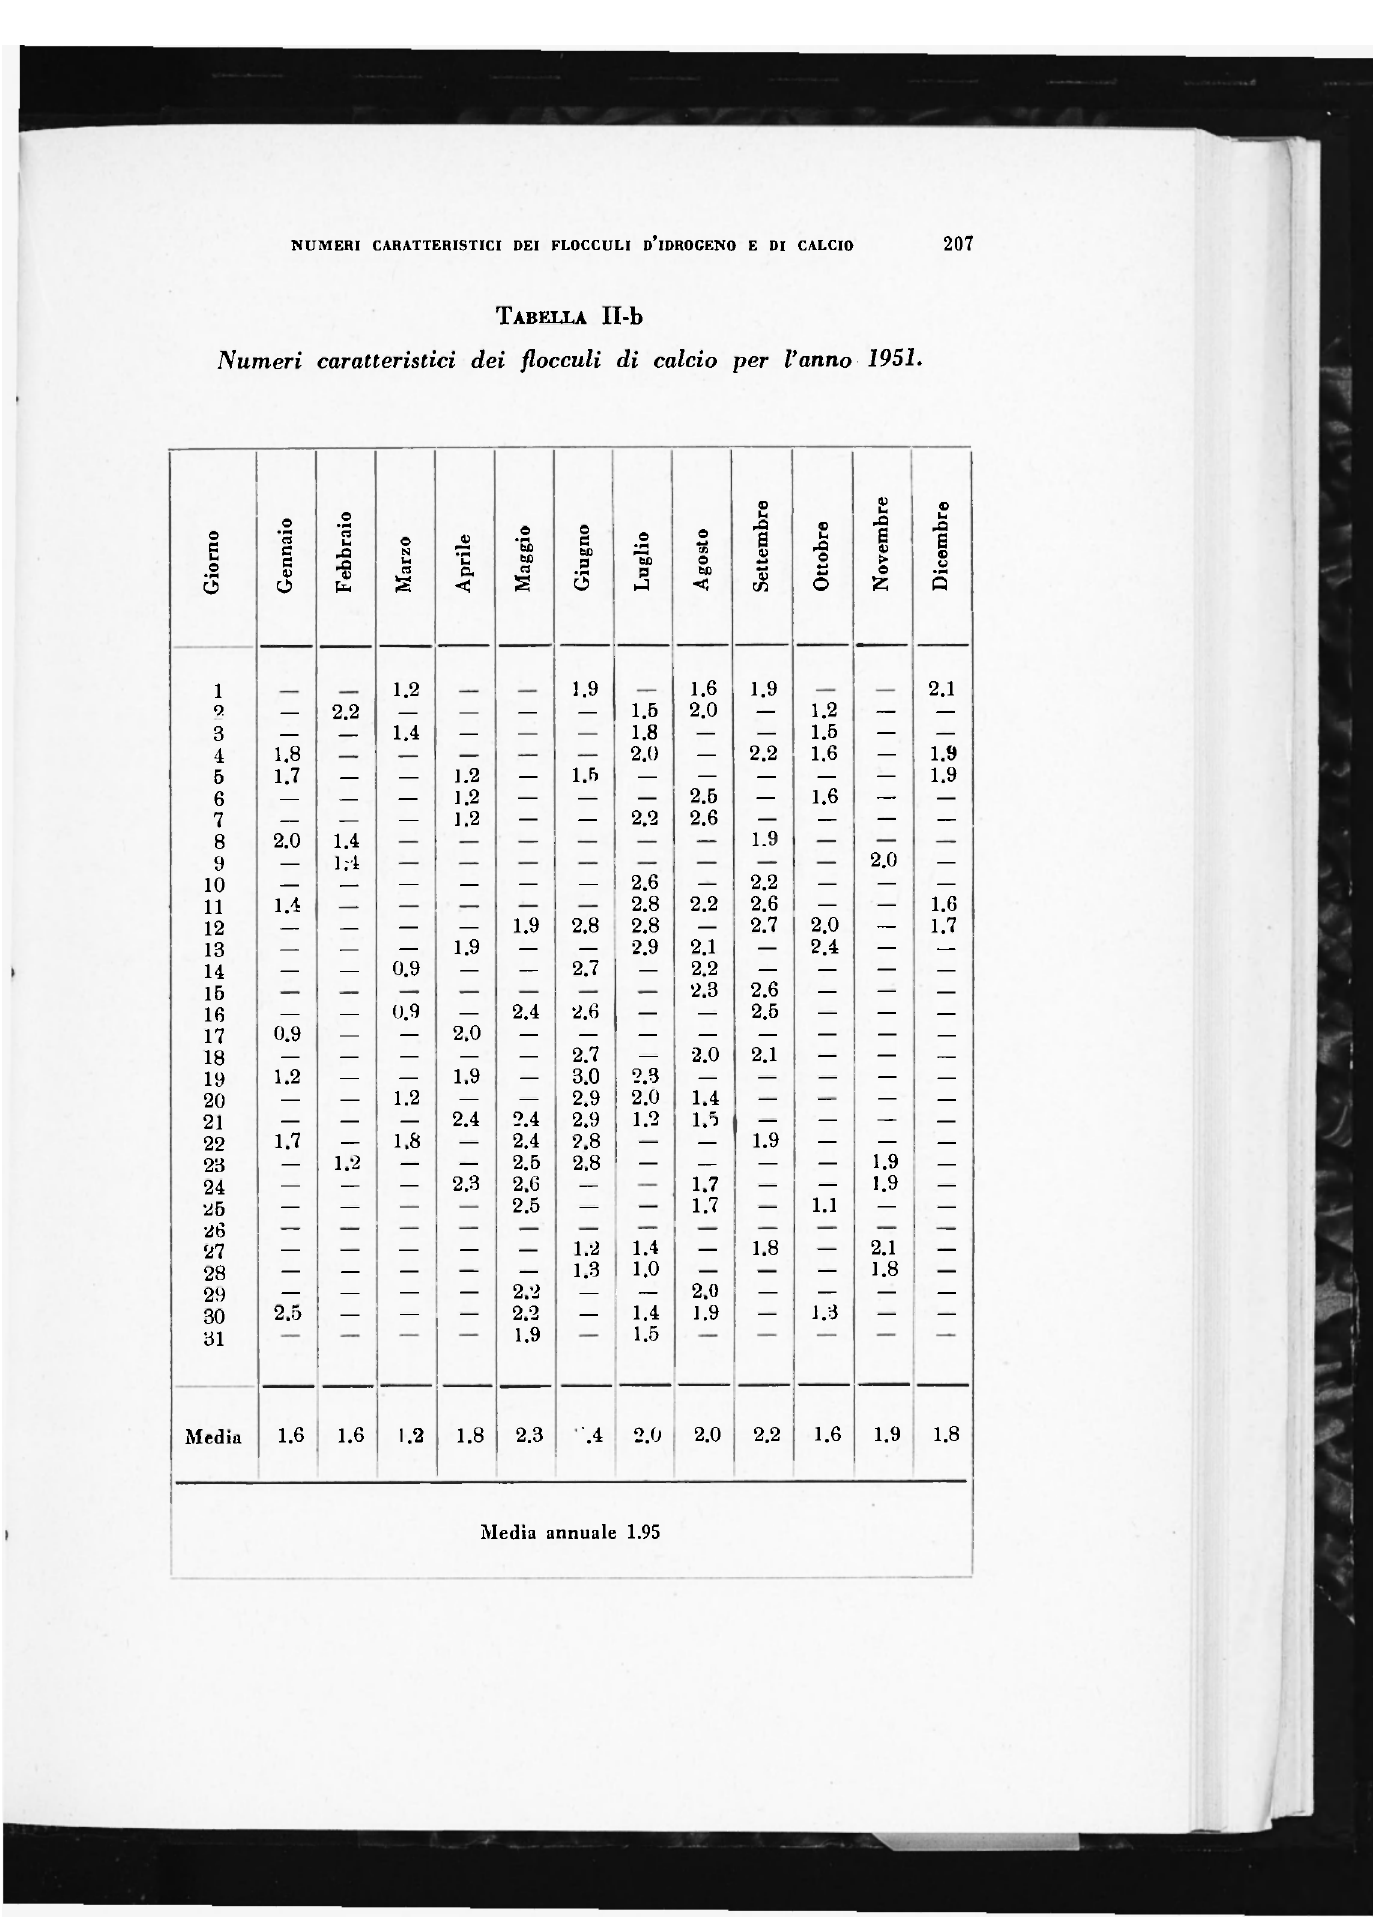
Numeri caratteristici